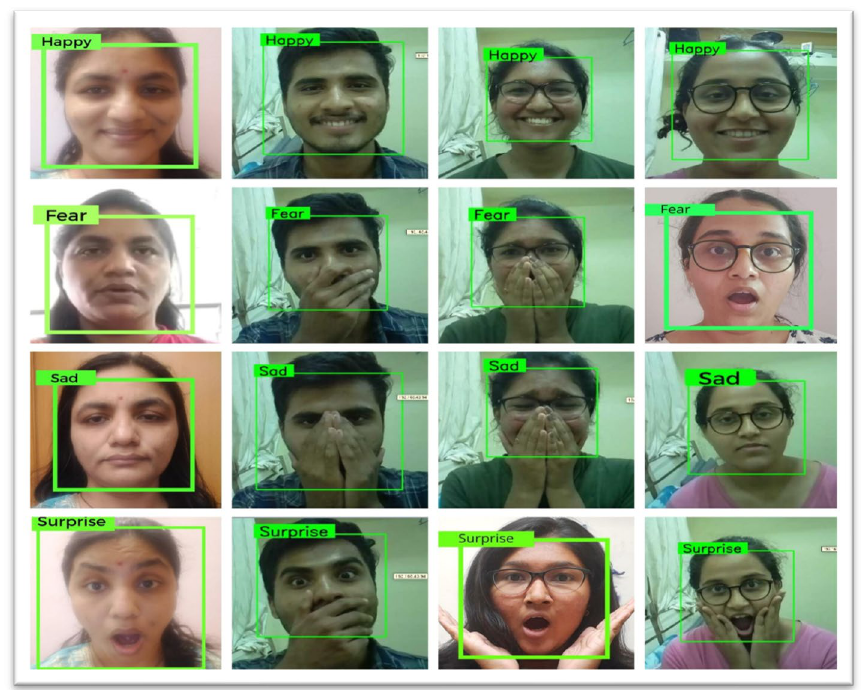
Fig. 22 The representation of facial expressions in terms of the emotion matrix of four participants identified on the framework of the raspberry pi